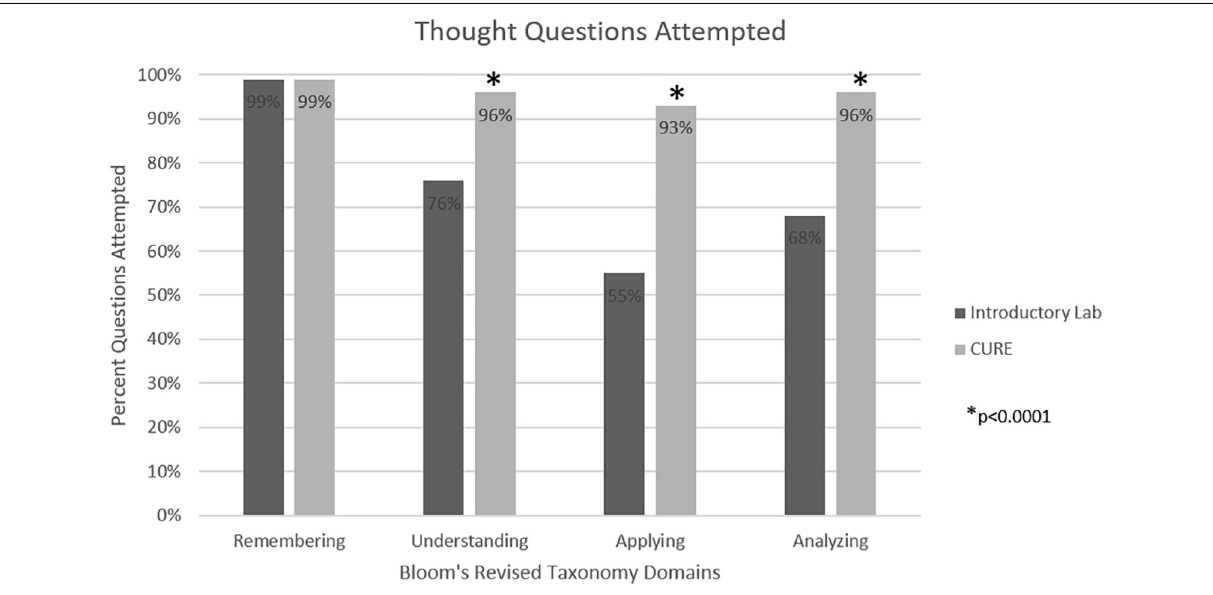
FIGURE 1 | Attempted responses. Comparison of the percent of students who attempted Thought Question at each domain of the Bloom’s Revised Taxonomy scale (remembering) after the introductory and CURE labs. *p <